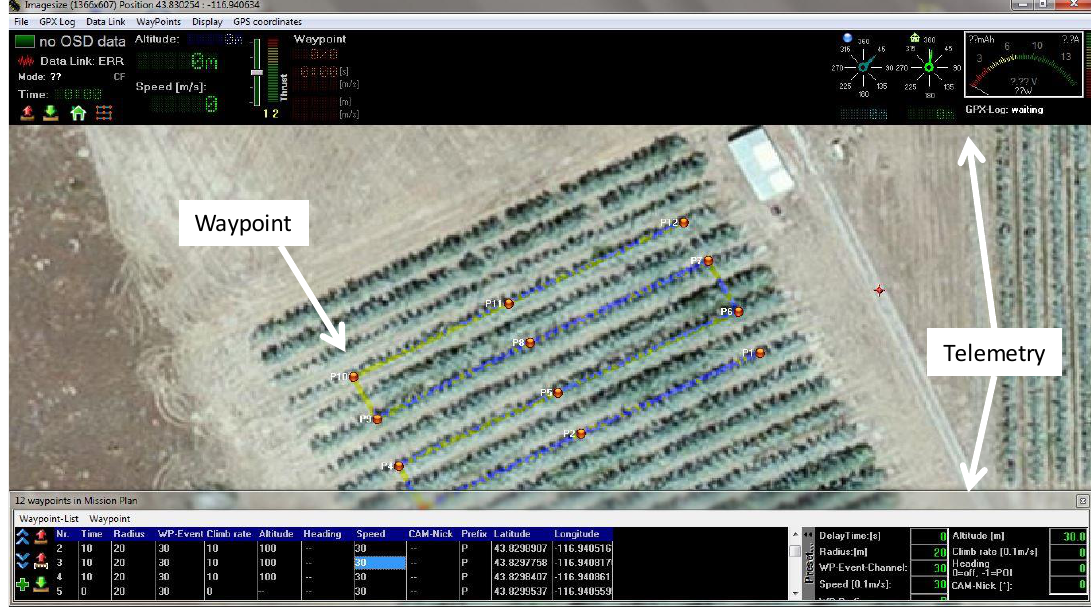
Figure 5. MikroKopter Tool On-Screen-Display for waypoint planning.